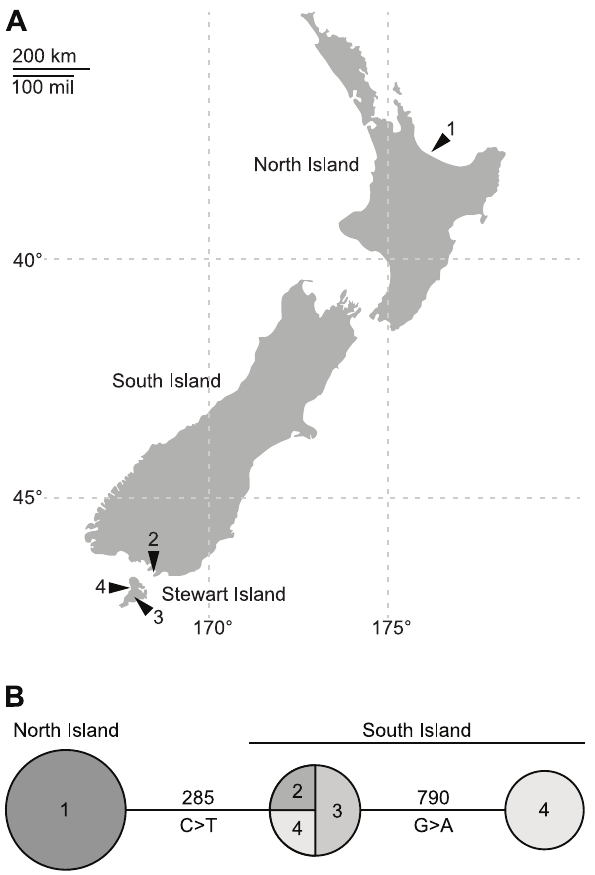
Figure 2. New Zealand Dotterel sample locations and haplo- types. A) Distribution of sample sites. Northern population: 1, Bay of Plenty (7 samples). Southern population: 2, Awarua Bay (1 sample); 3, Table Hill (2 samples); 4, Mason Bay (4 samples). B) Cytochrome b haplotype genealogy. Circle radius indicates quantity of individuals; numbers in circles refer to sample locations shown